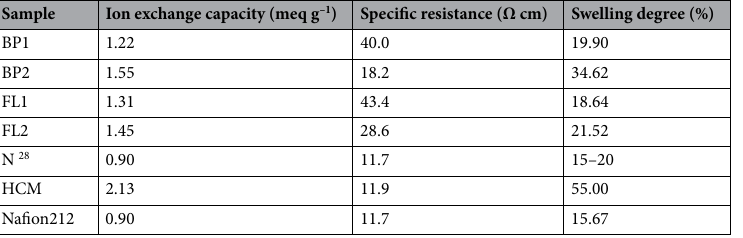
Table 1. Properties of the ionomers and membranes used in this study. BP1, BP2, FL1, and FL2 indicate SPES ionomers synthesized with biphenyl and fluorenyl groups, respectively. N represents the Nafion ionomer of